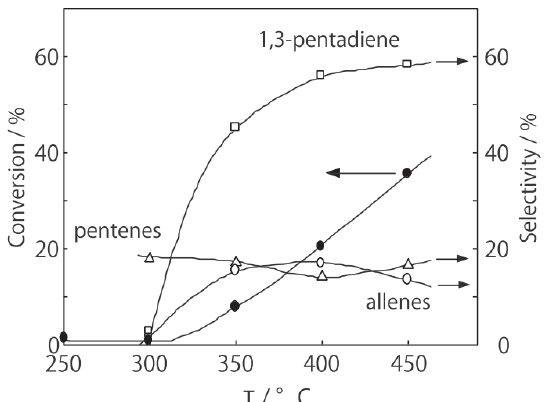
Figure 31. Effect of temperature on the reaction of 2-pentyne over [(Ta under flowing nitrogen. Following activation of the cluster (80 mg, 46 μmol) in a nitrogen stream (1.8 L/h) for 1 h, the reaction was initiated by introduction of 2-pentyne (52 μL/h, 0.50 mmol/h) into the nitrogen stream without changing the temperature. Conversion of 2-pentyne (●); selectivity for 1,3-pentadiene (□); selectivity for 1,2- and 2,3-pentadienes (○); and selectivity for 1- and 2-pentenes (∆) at 3 h after the start of the